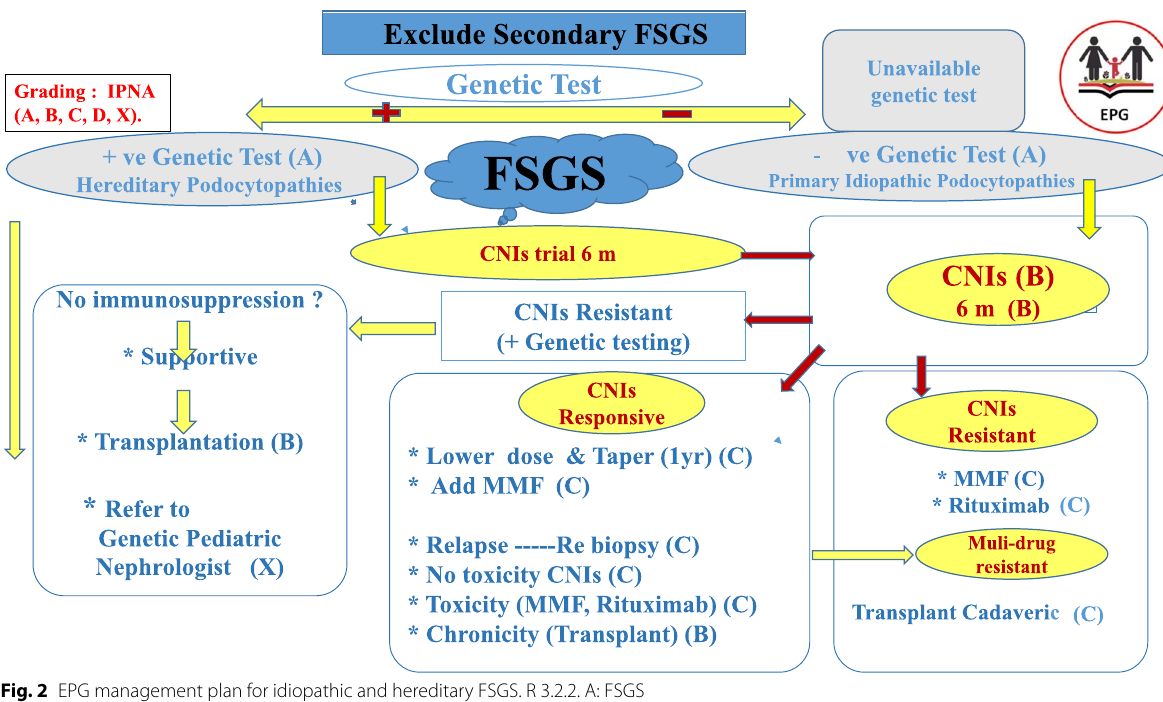
Fig. 2 EPG management plan for idiopathic and hereditary FSGS. R 3.2.2. A: FSGS